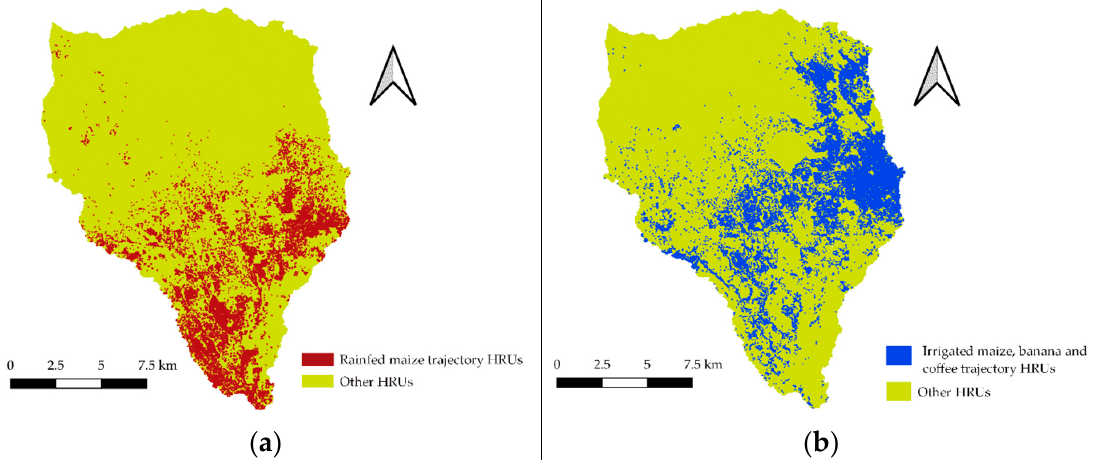
Figure 3. ( a ) HRUs for implementation of rainfed maize to irrigated mixed crops to irrigated mixed crops trajectory and ( b ) HRUs for the implementation of irrigated banana, coffee, and maize to irrigated banana and coffee to irrigated banana, coffee, and maize trajectory.